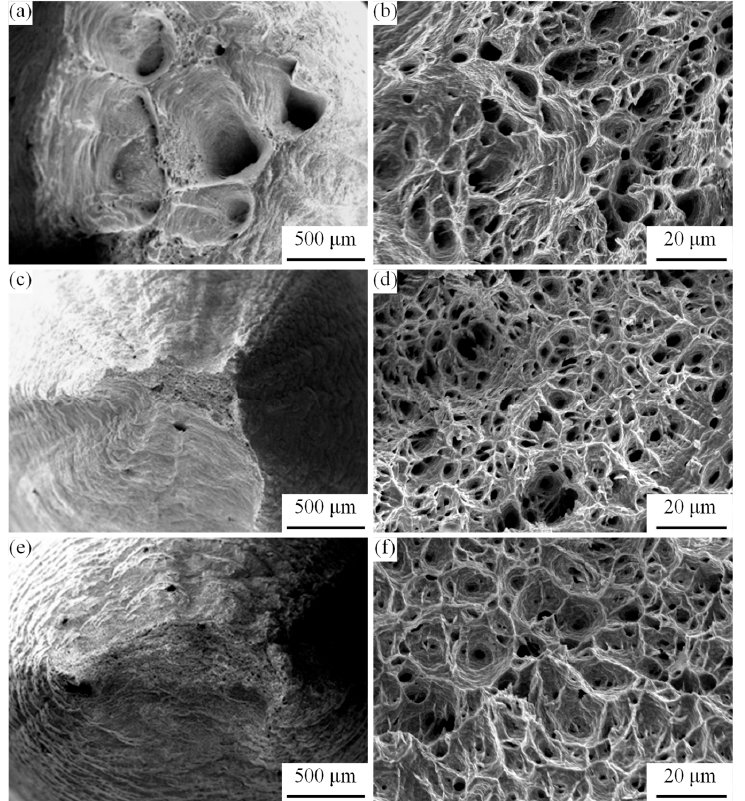
Figure 10. SEM images of the tensile fracture surfaces of the alloys at 750 °C: ( a , b ) 0Zr-4O alloy; ( c , d ) 0Zr-6O alloy; ( e , f ) 0Zr-10O alloy. ( a , c , e ) The entire fracture surfaces; ( b , d , f ) the enlarged images of fracture surfaces.